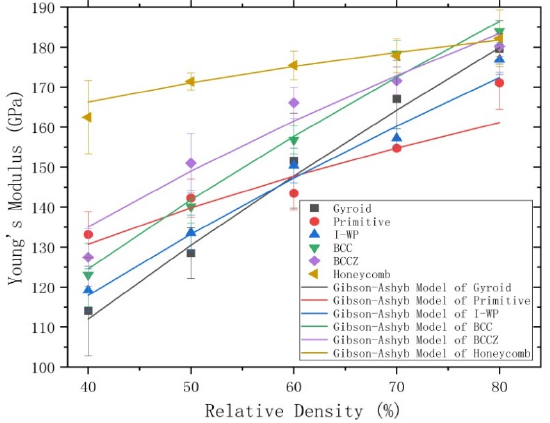
Figure 8. Comparison of the Young’s modulus of the six types lattice structures fitted by the Gibson-Ashby model.